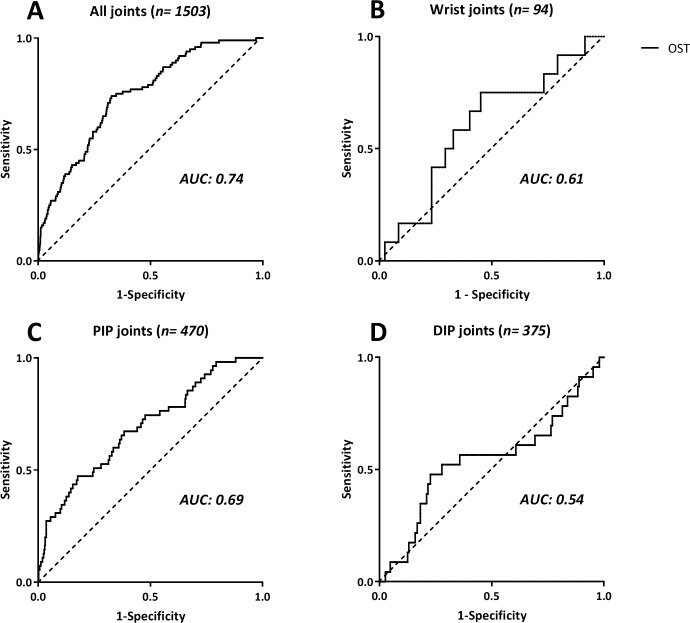
Receiver Operating Characteristic (ROC) curves.Areas under the curves (AUC) for optical spectral transmission (OST) in demonstrating ultrasonography observed synovitis (US synovitis) in A) all joints together (AUC-ROC: 0.74, 95%-CI: 0.70 to 0.79, p<0.001), B) wrist joints (AUC-ROC: 0.61, 95%-CI: 0.44 to 0.77, p = 0.234), C) PIP joints (AUC-ROC: 0.69, 95%-CI: 0.62 to 0.77, p<0.001), and D) DIP joints (AUC-ROC: 0.54, 95%-CI: 0.41 to 0.68, p = 0.486).